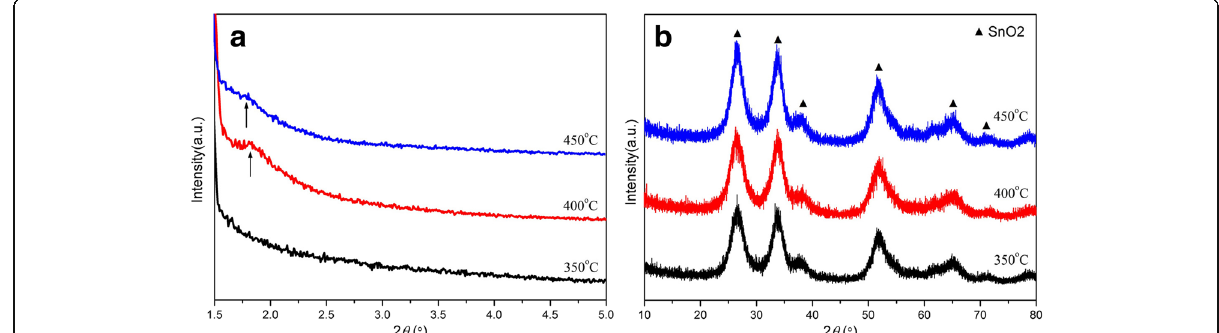
Fig. 2 a Small-angle and b wide-angle XRD patterns of mesoporous SnO 2 powders